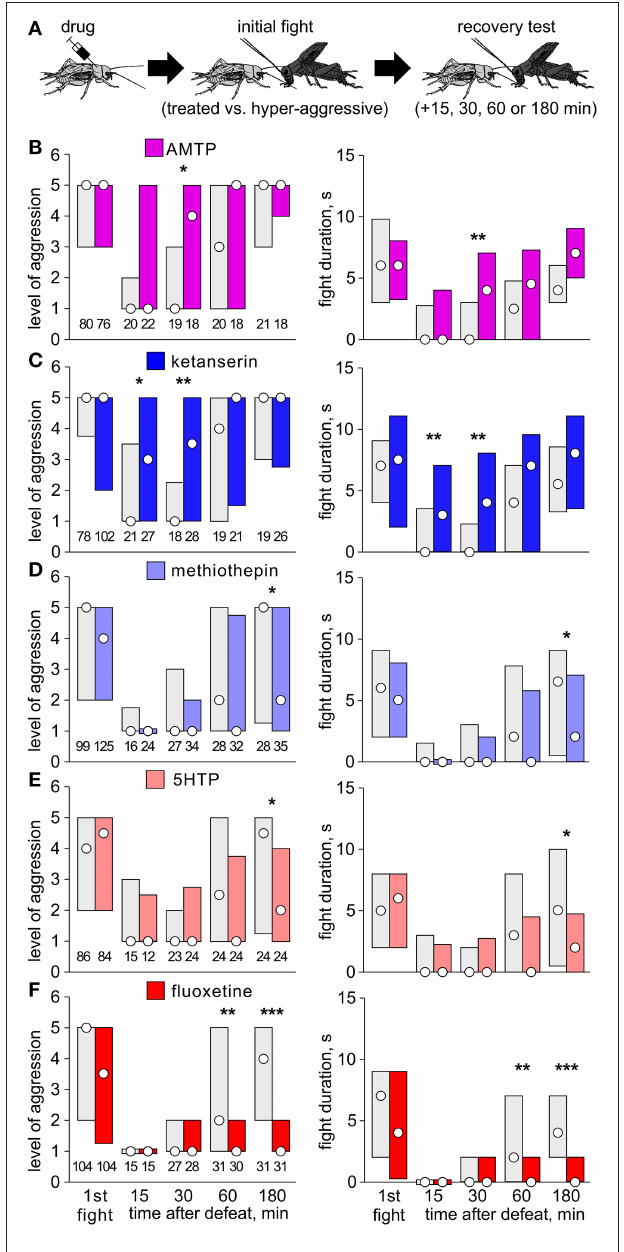
FIGURE 1 | Effect of serotonergic drugs on initial fights and loser depression. (A) Procedure: Test crickets received vehicle or drug 60min before an initial fight against a hyper-aggressive opponent. Separate cohorts of losers were then rematched at different times after defeat. (B–F) Level of aggression (left) and fight duration (right, circle: median, bars: interquartile range, IQR; n is given above the left x-axis) for crickets that received vehicle (gray bars) or (B) AMTP (violet bars); (C) ketanserin (dark blue bars); (D) methiothepin (light blue bars); (E) 5HTP (pink bars); (F) fluoxetine (red bars). Asterisks indicate significant differences between test and control groups as given by Mann-Whitney U-tests (*, **, ***: p < 0.05, 0.01, 0.001 respectively, otherwise not significant).